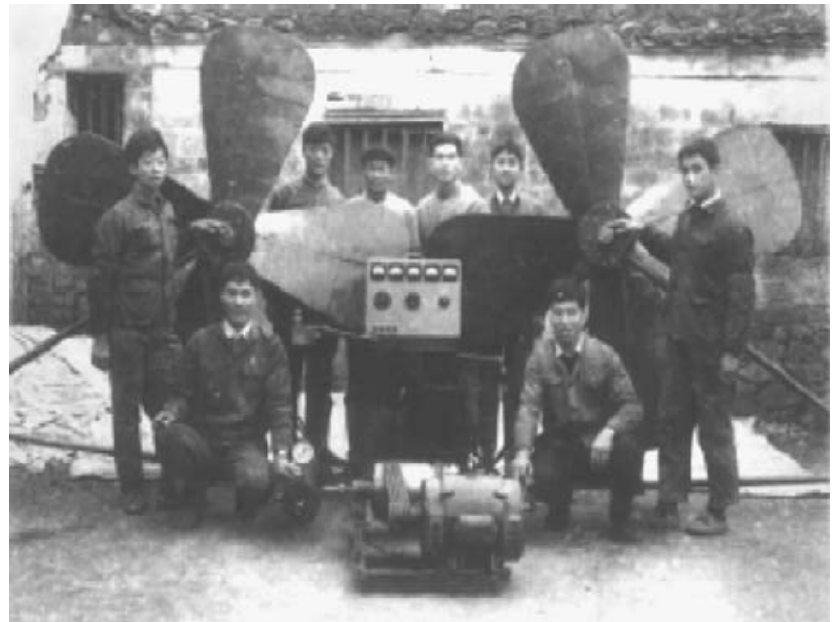
Figure 2. The first tidal current turbine in China in 1970s. Reproduced from [6], Elsevier.